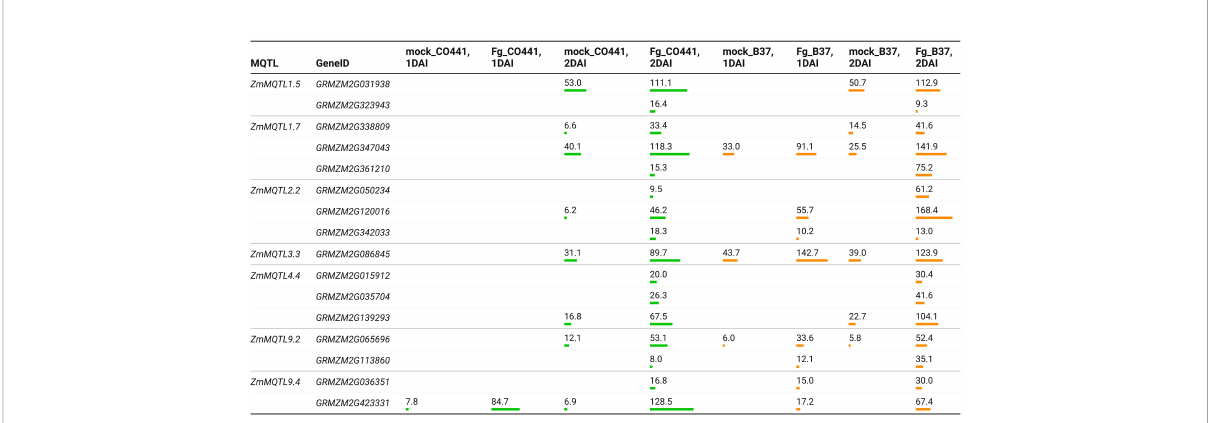
FIGURE 4 Expression levels in transcripts per million (TPM) of the common candidate genes in resistant (CO441) and susceptible (B37) lines under control conditions (mock) vs. F. graminearum (Fg) comparisons. Bar charts show the relative importance of the expression levels of each gene. MQTL, meta-QTL; DAI, days after inoculation.